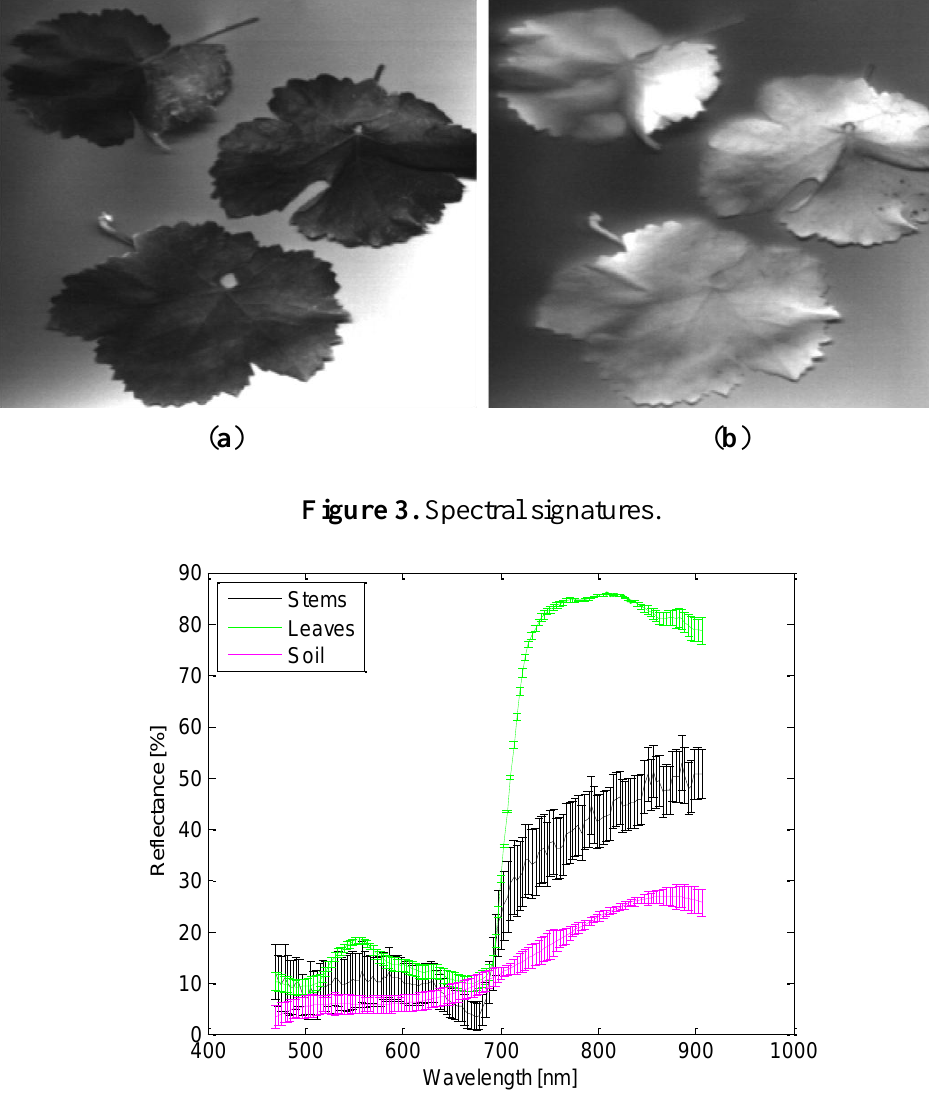
Figure 2. Narrow band images of grapevine leaves. ( a ) Image at 635 nm; ( b ) Image at 750 nm.